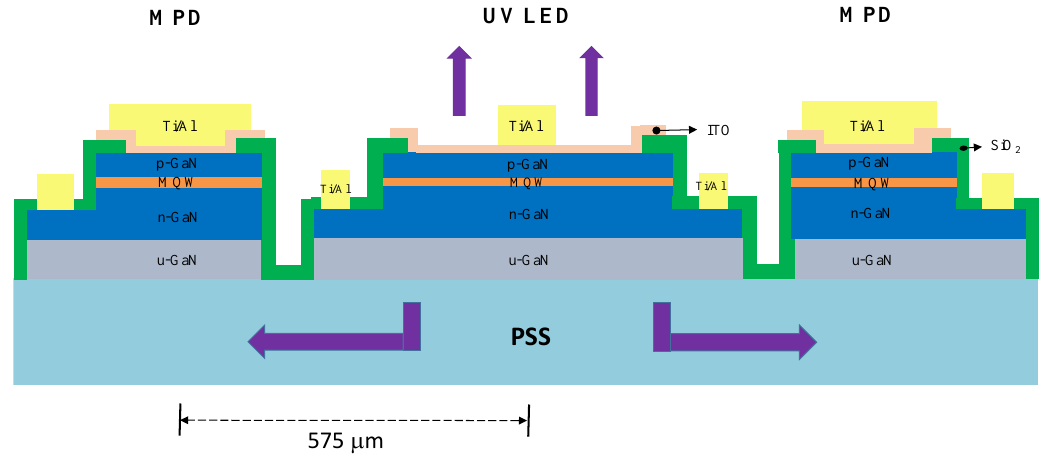
Figure 1. Schematic structure of the monolithic UV LED and MPD, where ITO and PSS represent indium-tin oxide and patterned sapphire substrate, respectively.